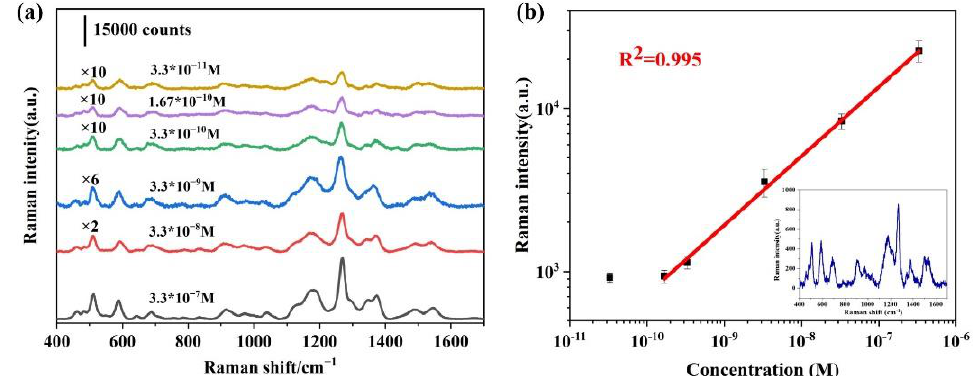
Figure 7. ( a ) SERS spectra of TBA-MDA with different concentrations ( b ) SERS intensity of TBA- MDA at 1272 cm −1 as a function of the MDA concentration. The inset shows the SERS spectrum of TBA-MDA adduct at 3.3 × 10 −11 M. The concentrations shown here were sample concentrations before injection into the chip.